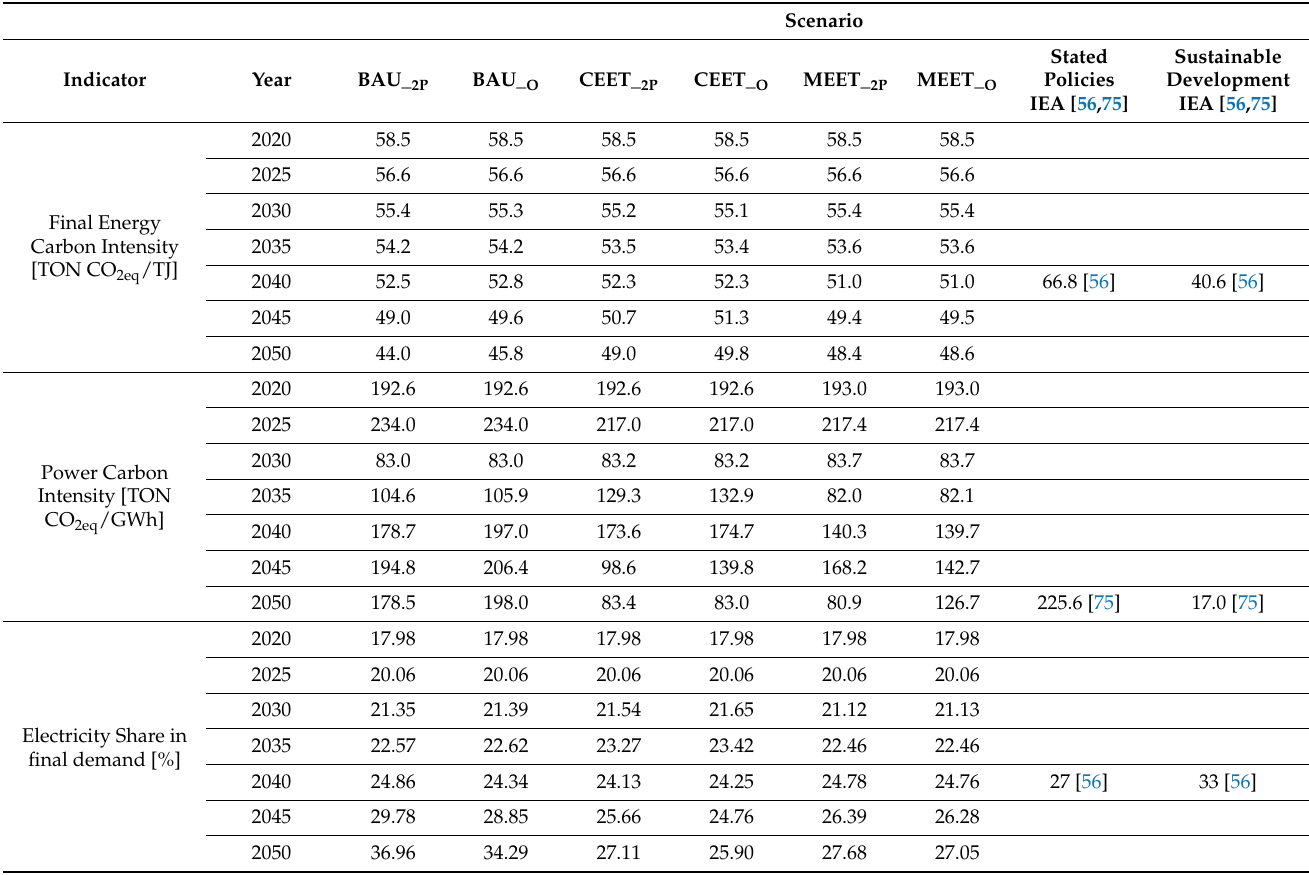
Table 4. Evolution of Energy Transition Indicators per